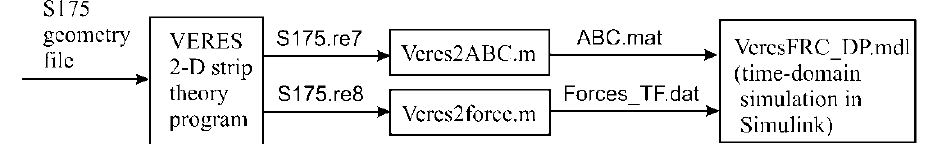
Figure 3. Flow chart showing the numerical